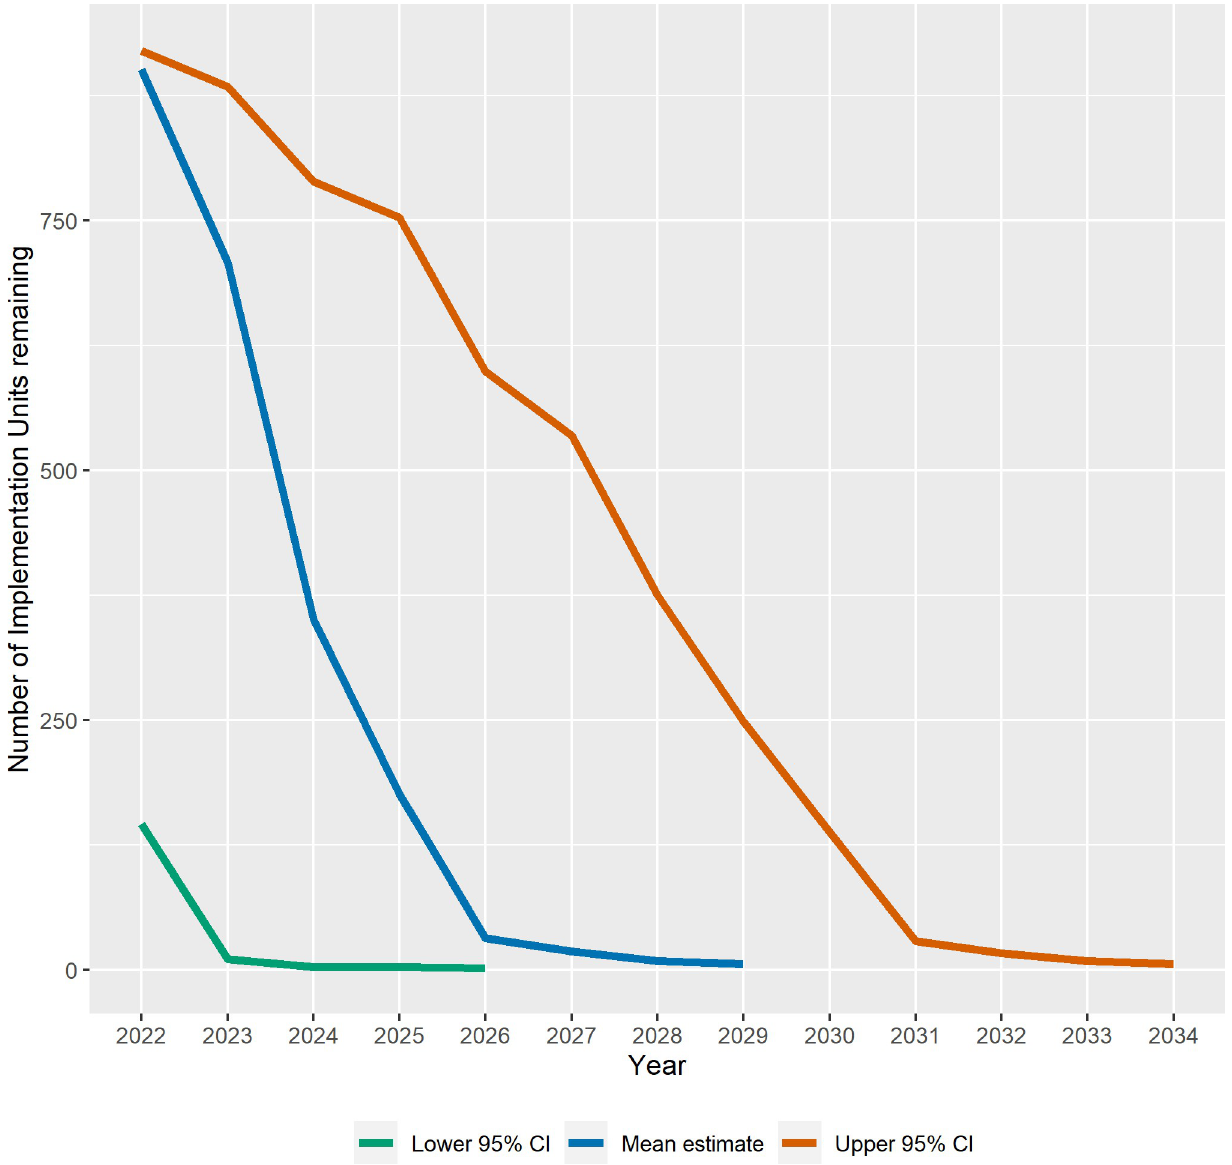
Fig 1. The mean, lower 95% CI, and upper 95% CI forecast number of Implementation Units remaining requiring Mass Drug Administration by